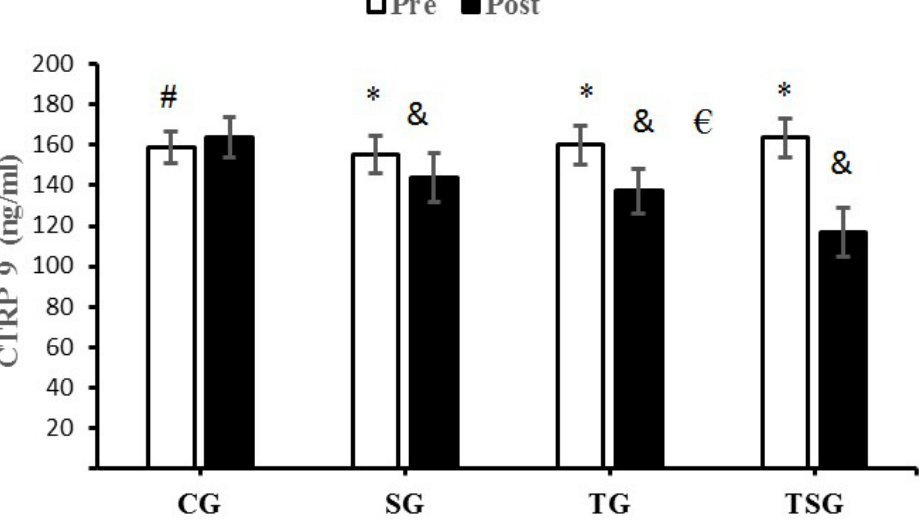
Figure 1. Pre- and post-training values (mean ± SD) for CTRP9 in the control (CG), supplement (SG), training (TG), training + supplement (TSG) groups. & Significant differences with pretest values ( p < 0.05). * Significant differences with the control group ( p < 0.05). # Significant interaction between time and group ( p < 0.05). € Significant time X group interaction ( p < 0.05).